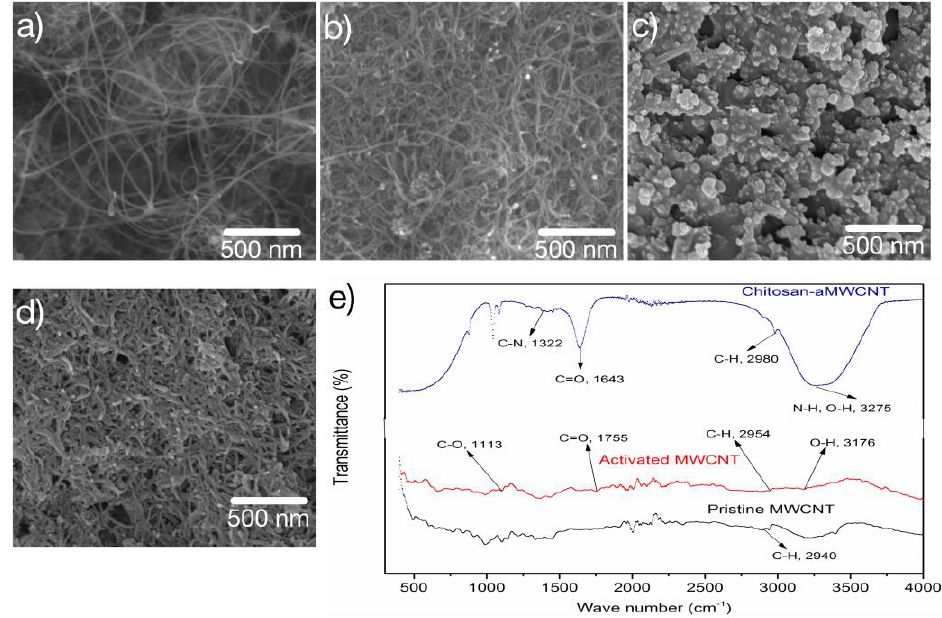
Figure 2. Field emission scanning electron microscope (FESEM) images of ( a ) Pristine multi-walled